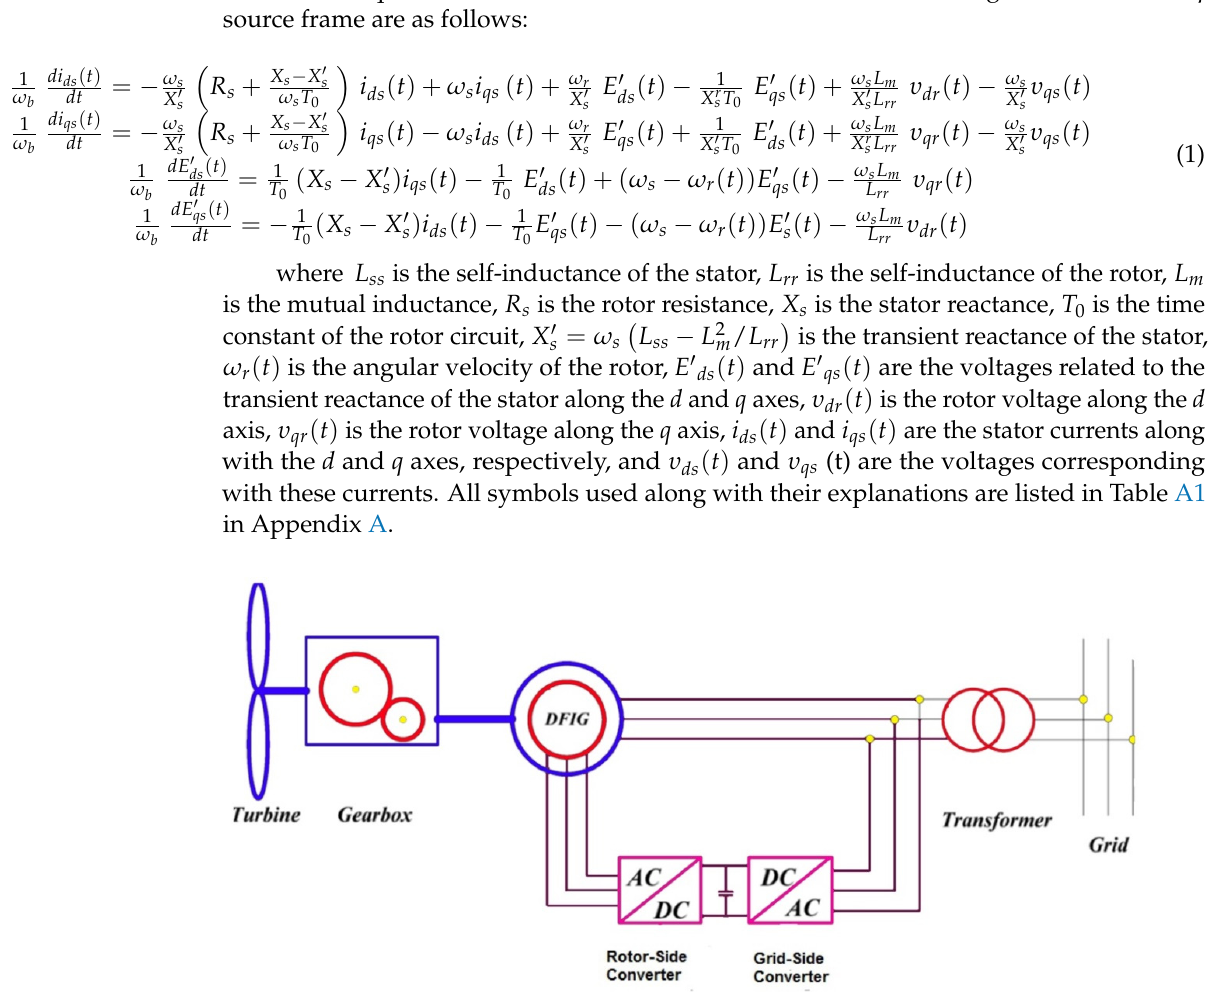
Figure 1. Wind turbine diagram with the DFIG.